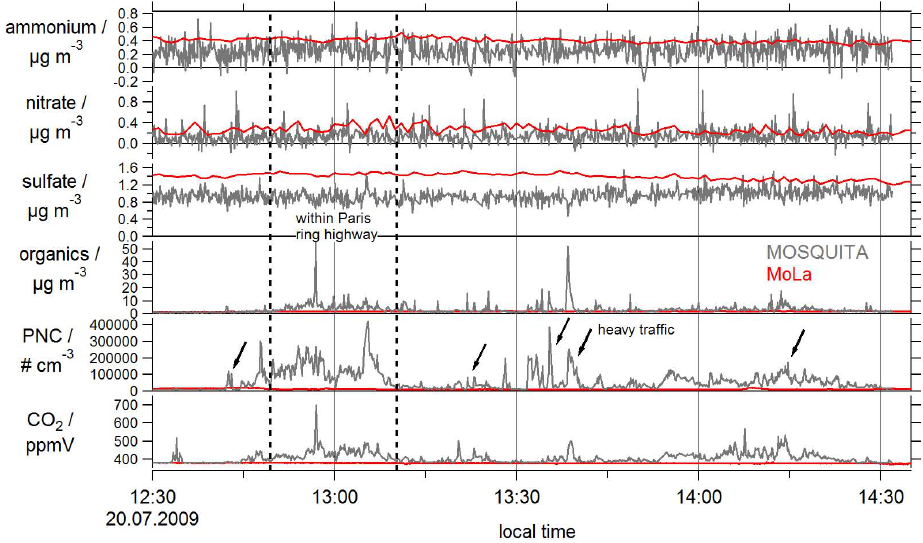
Fig. 3. Temporal behaviour of aerosol parameters primarily associated with long-range transported pollution (ammonium, nitrate and sulfate) and variables reflecting mainly locally and regionally produced pollution (organics, particle number concentration (PNC, >2.5nm for MoLa and >10nm for MOSQUITA) and CO 2 ) . The red lines represent the MoLa stationary measurement data and the grey lines the MOSQUITA mobile measurement data. The two vertical dashed lines frame the mobile measurement range within the city area of Paris; the arrows indicate measurement times with heavy traffic on the street. The time series were measured by MOSQUITA (outward trip) and MoLa during the summer campaign on 20 July 2009. The time resolution of the data is 1–7s (MOSQUITA) and 1–60s (MoLa). The stationary measurement location of MoLa and the mobile measurement track (outward trip) of MOSQUITA are marked in the map of Fig.